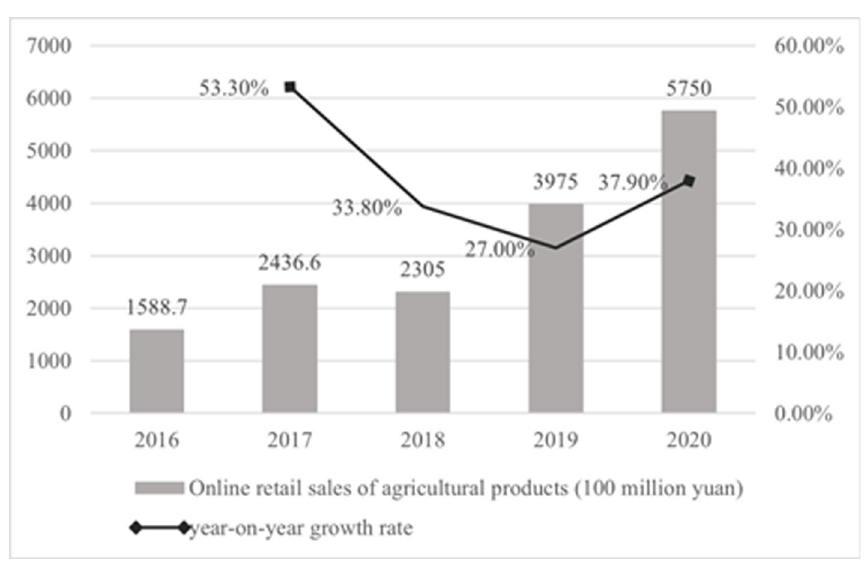
Fig 3. Agricultural products online retail sales and year-on-year growth rate in China from 2016 to 2020. Source: Ministry of Commerce of the People’s Republic of China.